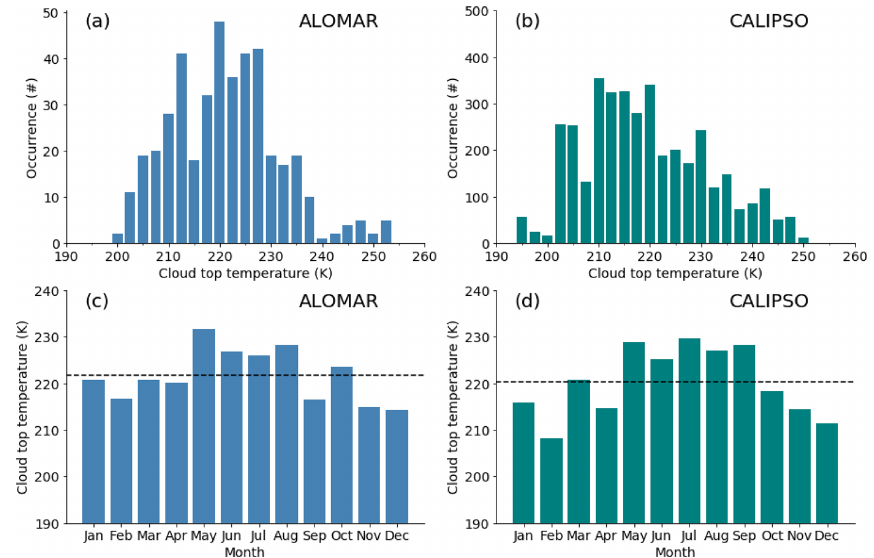
Figure 7. (a, b) Histogram of cloud top temperatures for all cirrus detections from (a) the ground-based lidar and (b) the spaceborne lidar between 2011 and 2017. The bin width is 2.5K. For the ground-based lidar, the temperatures are interpolated from reanalysis data (ERA5) on pressure levels until 2014 and taken from radiosondes thereafter. (c, d) Monthly average cloud top temperature from (c) ground-based and (d) spaceborne